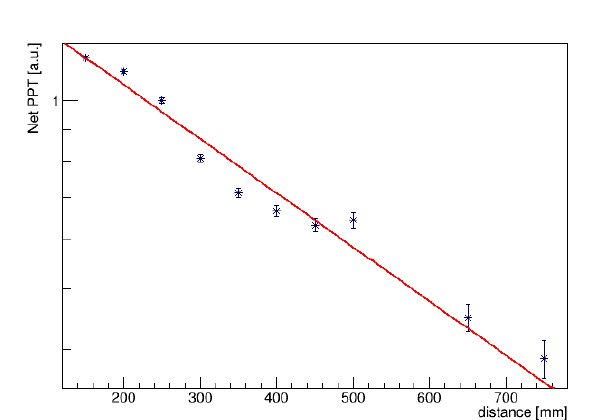
Fig. 11. Attenuation length data obtained from the net PPT values of the individual SiPMs (after correction for the solid angles). The exponential fit yields for this (non-pure) LAr sample an attenuation length of (50 ± 4)